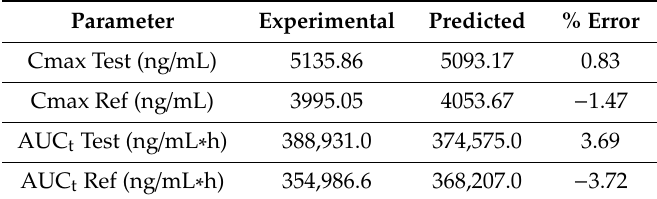
Figure 8. Experimental (symbols) and predicted (lines) in vitro fraction dissolved and plasma levels from reference and test formulations with the one-step IVIVC Level A approach. Table 7. Predictability analysis of the one-step IVIVC approach.